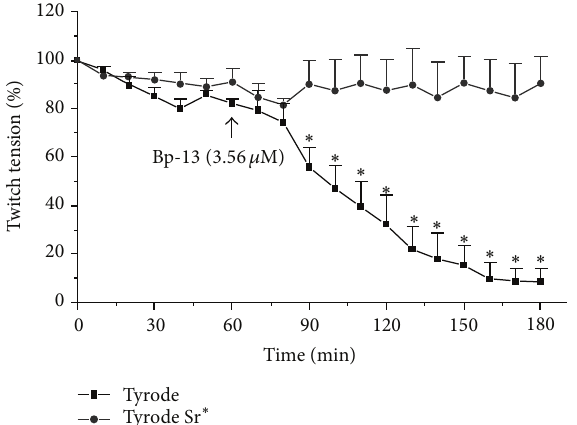
Figure 7: Twitch-tension response of indirectly stimulated EDL preparations incubated with 3.56 𝜇 M of Bp-13 in Tyrode and Tyrode Sr 2+ . Each point represents the mean ± SEM of 3–6 experiments; ∗ 𝑃 < 0.05 compared to control values. ANOVA and followed by Mann-Whitney test for comparison between two groups.